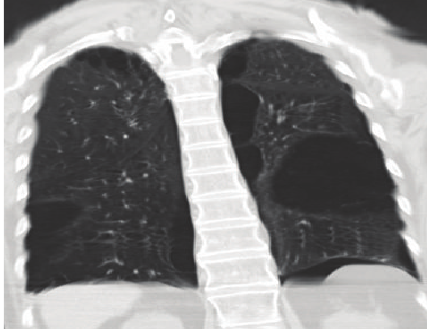
Figure 2: Chest CT coronal view showing bilateral lung bullae more than one-third of the left